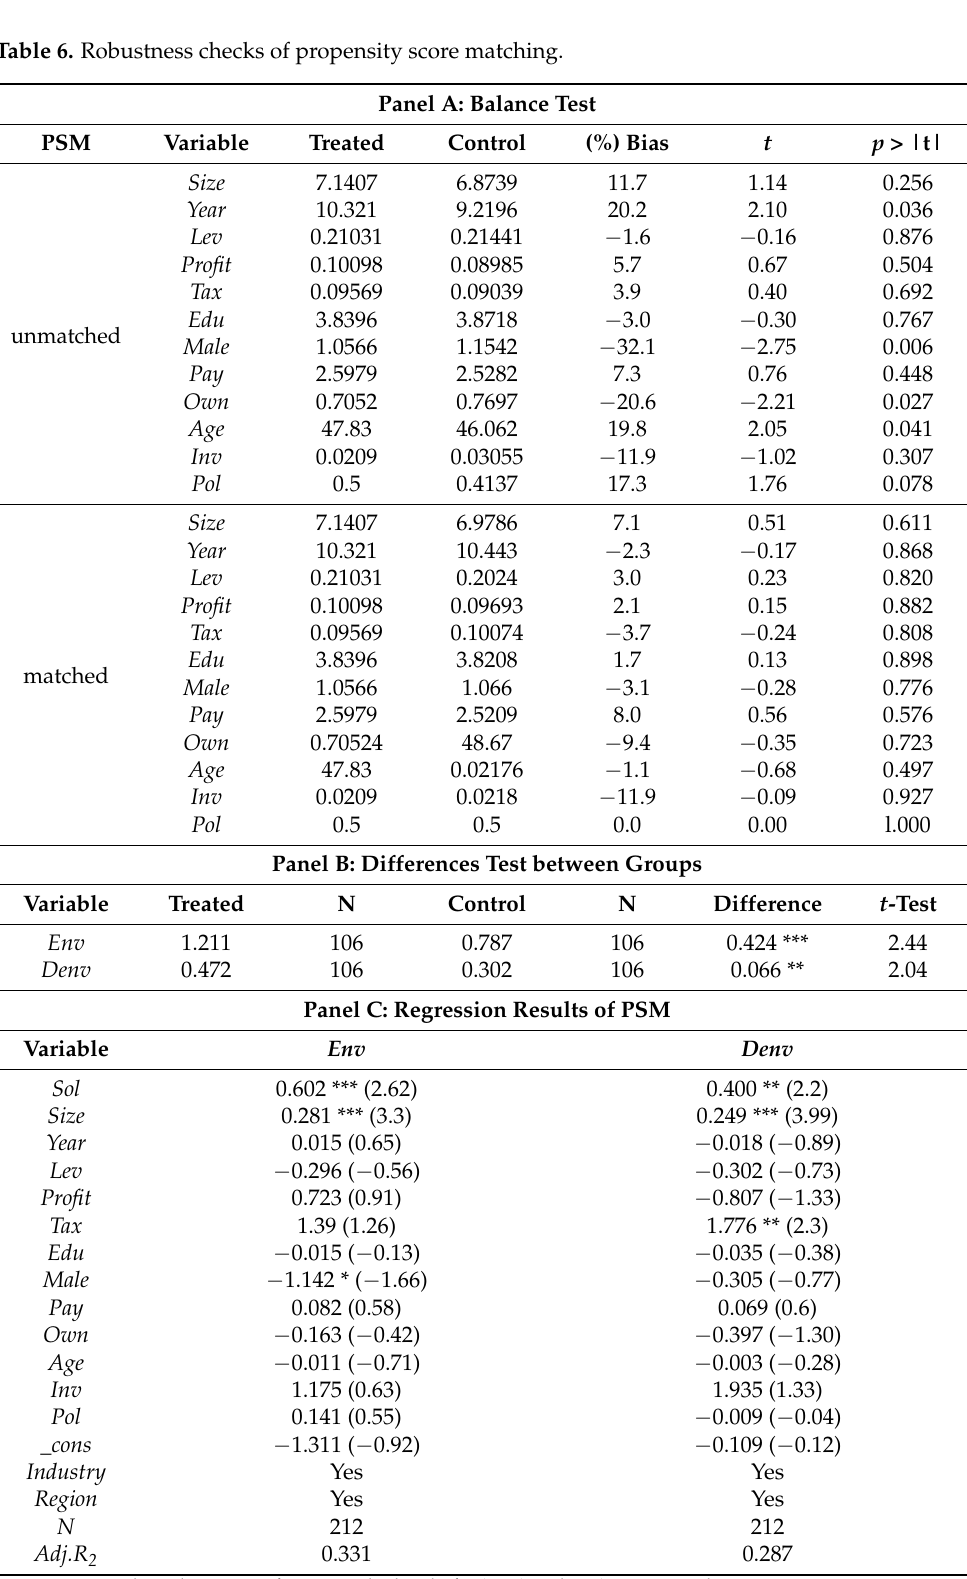
Table 6. Robustness checks of propensity score